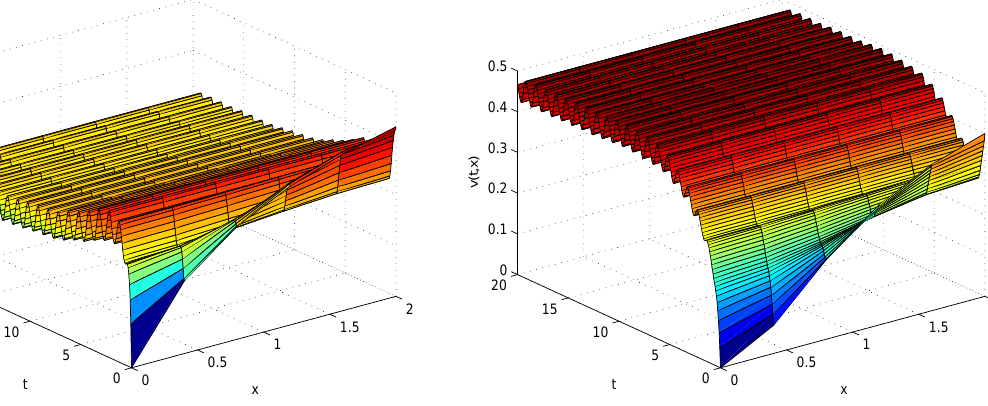
Fig. 3. Periodic prey solution with respect to the time and space variables.